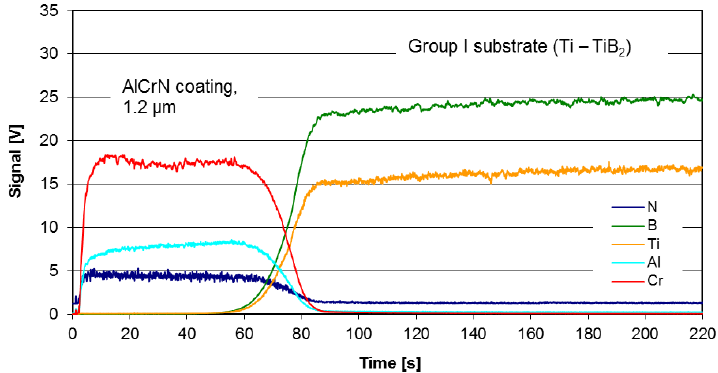
Figure 4. The GDOES profile: Group I substrate (Ti-TiB 2 ) with AlCrN coating.